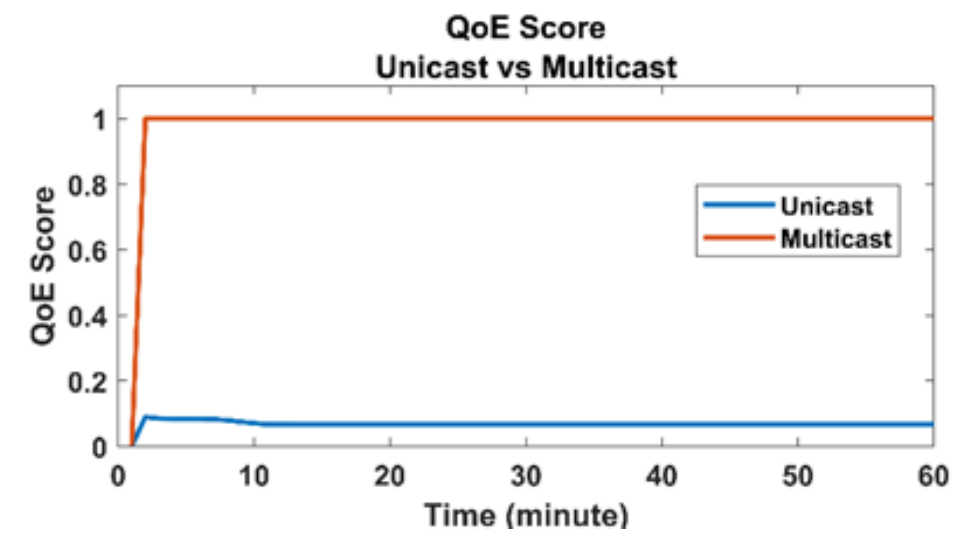
Figure 5. QoE score (multicast vs. unicast).